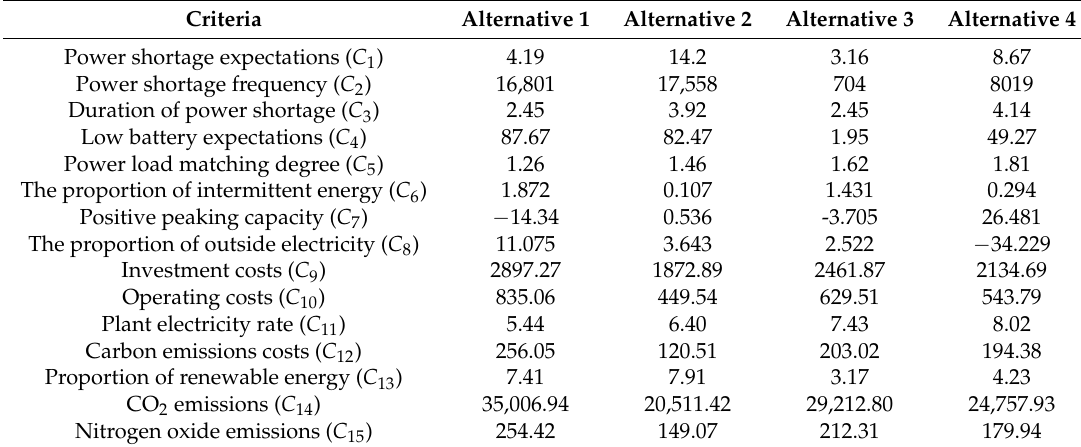
Table 1. The initial data for alternatives corresponding to each criterion. (Zhong et al., 2015).